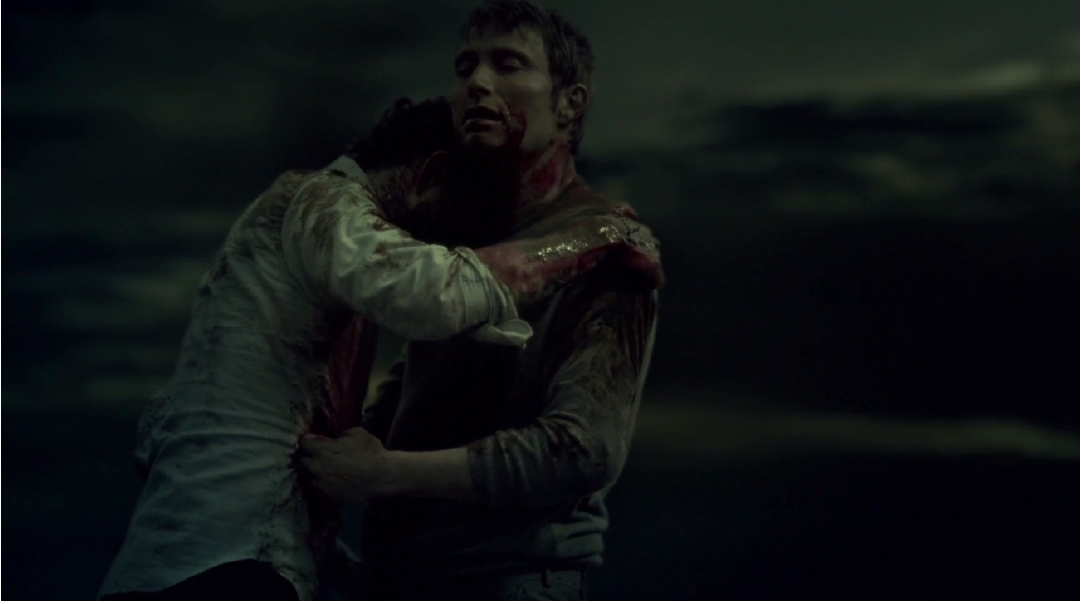
Figure 10. Will embraces his true nature by embracing Hannibal. Screencap from the thirteenth (and final) episode of season 3, “The Wrath of the